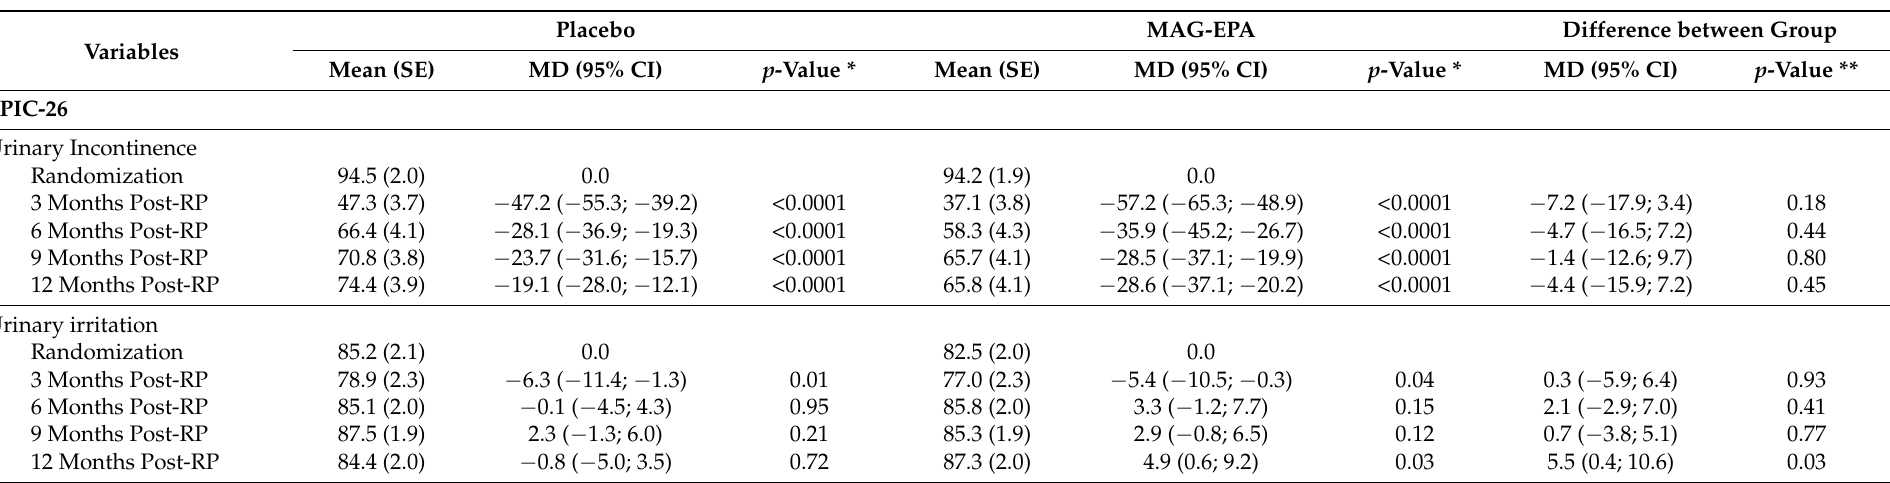
Table 3. Associations between quality-of-life functions and MAG-EPA intervention, per-protocol